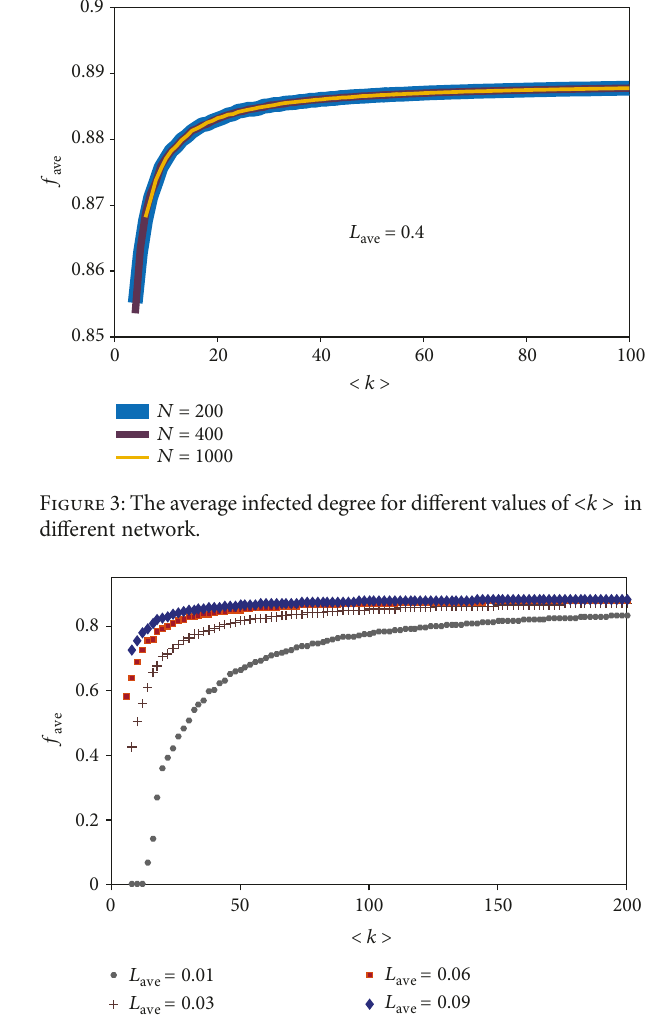
Figure 4: The evolution of the network varies with < k > under di ff erent average connection weights L ave